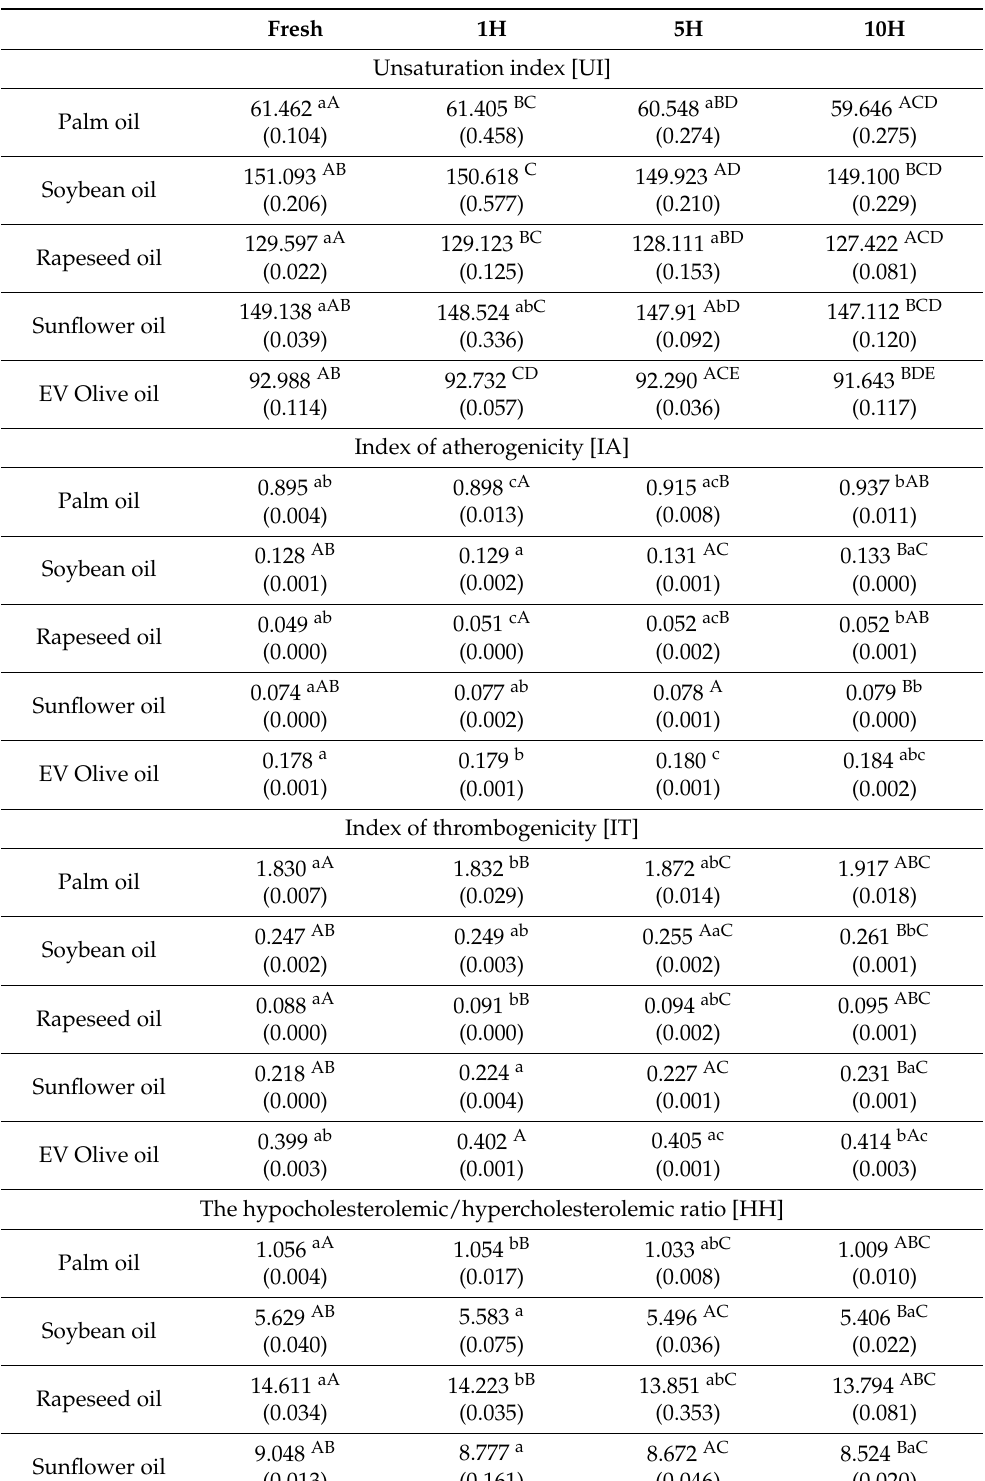
Table 2. Changes in nutritional indices in five different plant-based oils in fresh samples and after one (1H), five (5H) and ten heating sequences